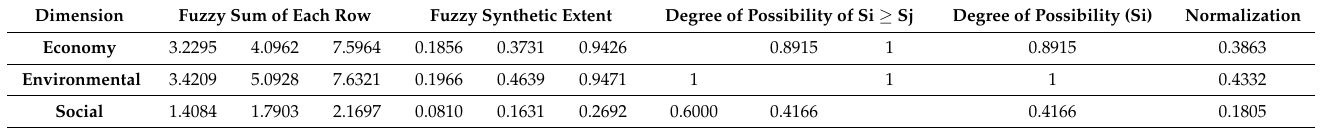
Table A3. Fuzzy Extent